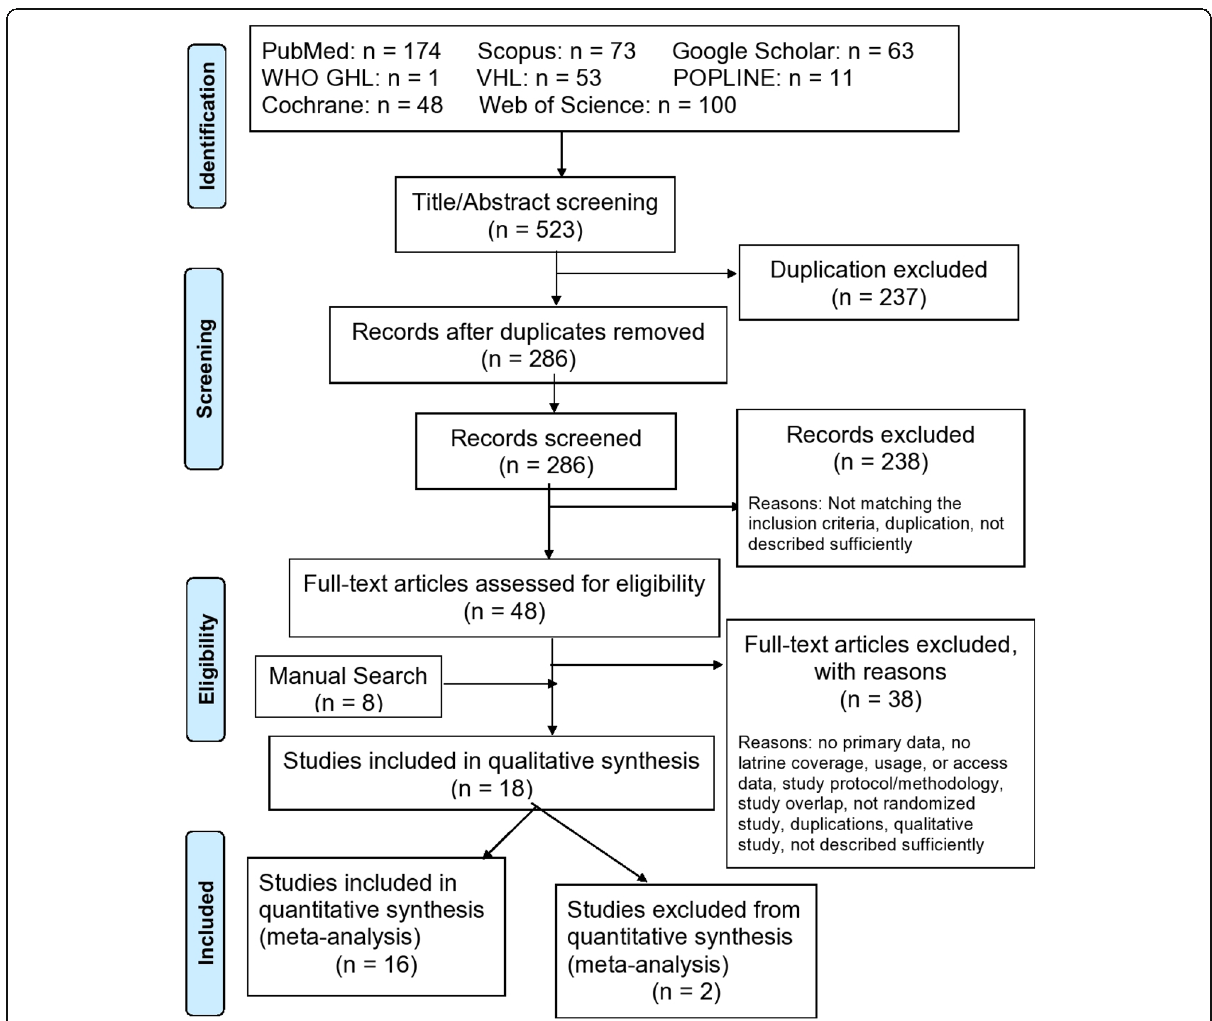
Fig. 1 Flow chart of the search and review procedure for the systematic